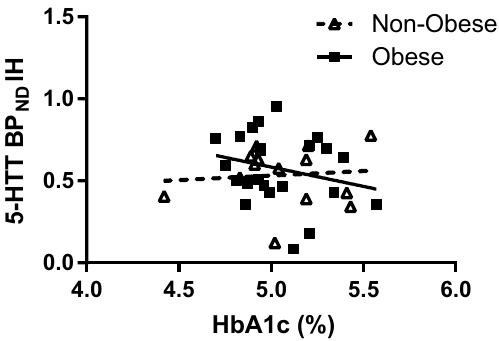
Figure 2. Scatterplot showing Pearson correlation between HbA1c levels and 5-HTT BP ND obtained with [ 11 C] DASB and PET in the left hippocampus (lH) individuals with obesity (r = − 0.57, p = 0.006) and non-obesity (r = 0.056, p = 0.76). The difference of regression coefficients was statistically significant (p =